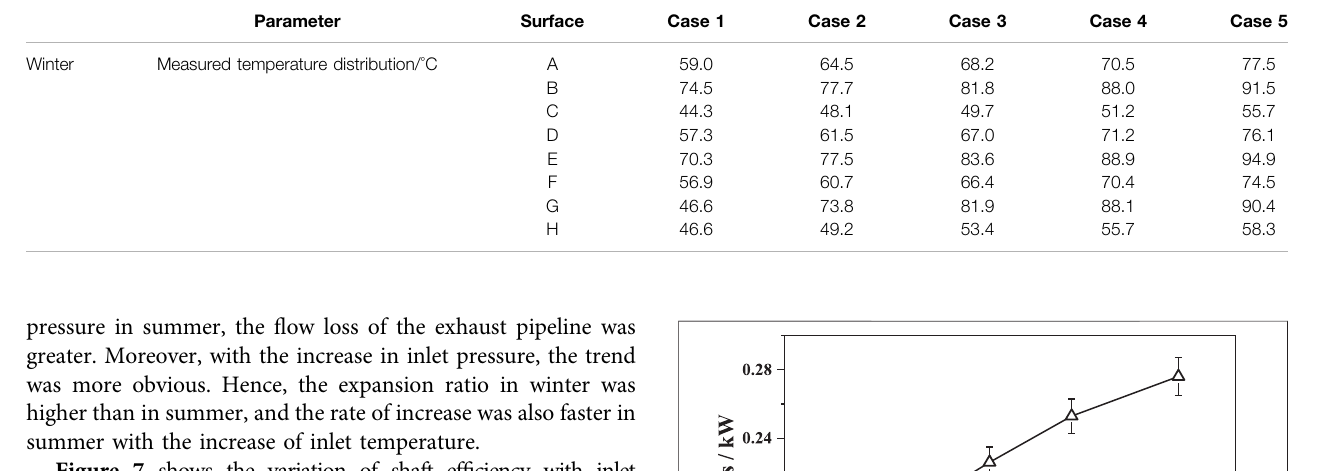
TABLE 5 | Surface temperature at different inlet temperatures in winter.